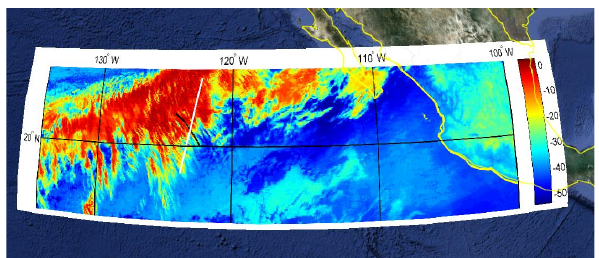
Fig. 2. Structure of a convective system in the eastern Pacific ocean (2 February 2008). Colors denote GOES brightness temperature (09:45:00UTC) difference between the 6.5 micron and 11 micron channels, with red denoting high, cold clouds. The black line is the GPS RO tangent point (09:53:00UTC) and the white line is the CALIPSO track